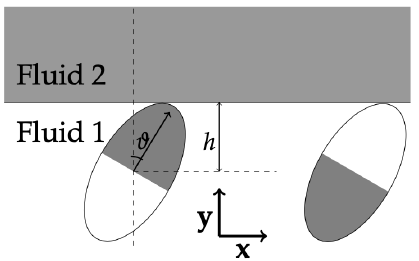
Figure 1. A single ellipsoidal Janus particle touching a fluid–fluid interface: h is the distance between the particle center and the flat fluid interface, ϑ is the particle orientation. Fluid 1 is defined as the fluid in which the particle is immersed in the beginning and fluid 2 is the fluid into which the particle enters. The dark area of the Janus particle prefers fluid 2 whereas the white area prefers fluid 1. The left particle is in the “preferred initial orientation” (PIO, 0 ≤ ϑ 0 < 90 ◦ ) and the right particle in the “unpreferred initial orientation” (UIO, 90 ◦ < ϑ 0 ≤ 180 ◦